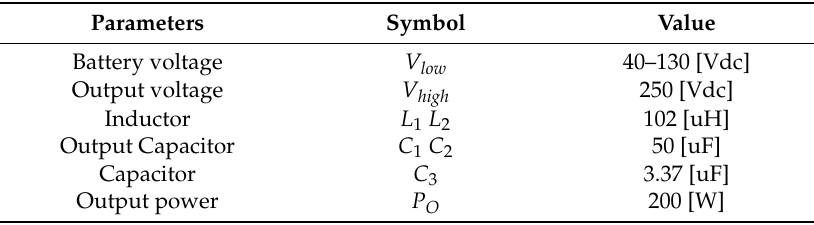
Figure 15. Bidirectional power flow control strategy of proposed converters.